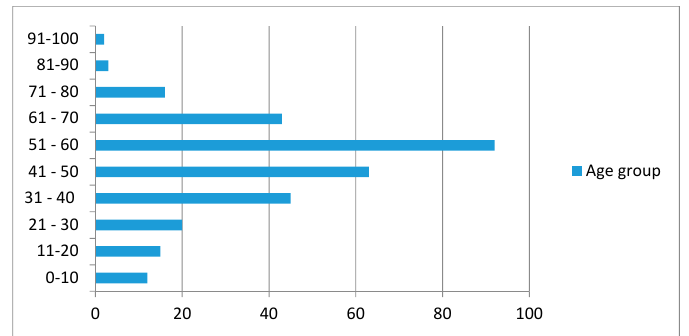
Figure 3. Age distribution of patients with melioidosis in Sri Lanka.